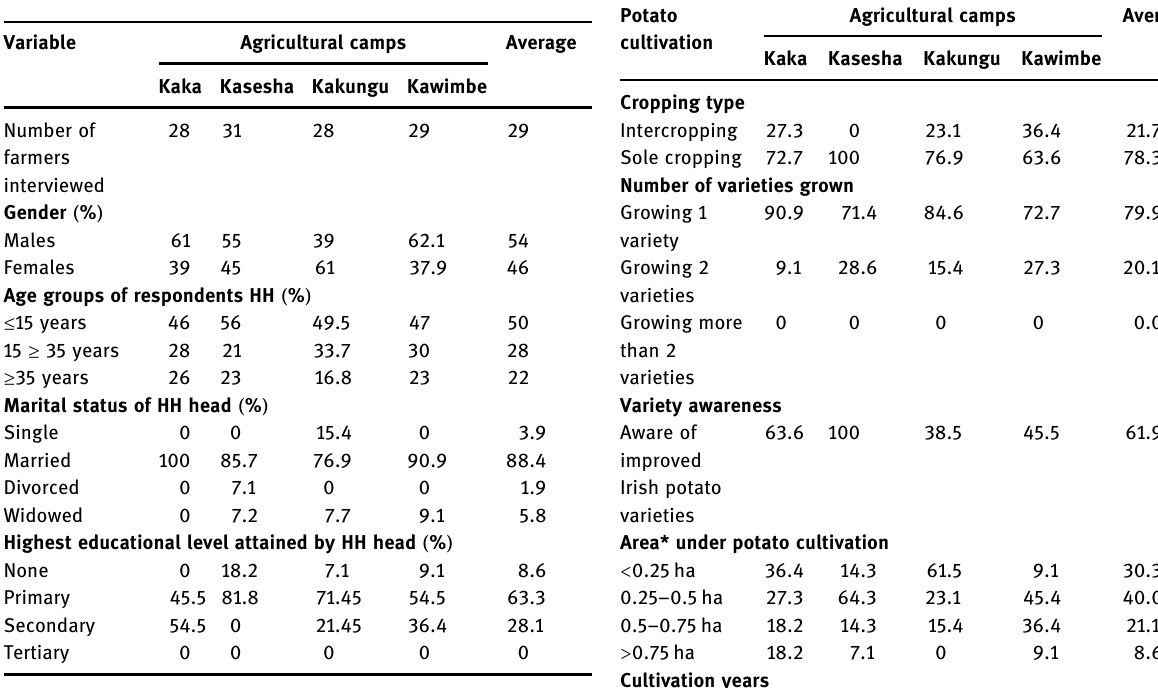
Table 2: Area under potato cultivation and cropping system men